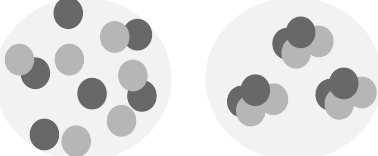
Figure 8.4: Two possible structures of the carbon Figure 4: The two possible options for the structure nucleus. On the left, the nucleons move randomly of the carbon nucleus. On the left we see 12 nucleons inside the nucleus. On the right, there are three clus- moving independently of each other and on the right we ters of ↵ particles and the ↵ particles move randomly inside the nucleus. see groups of 4 nucleons moving as a bound